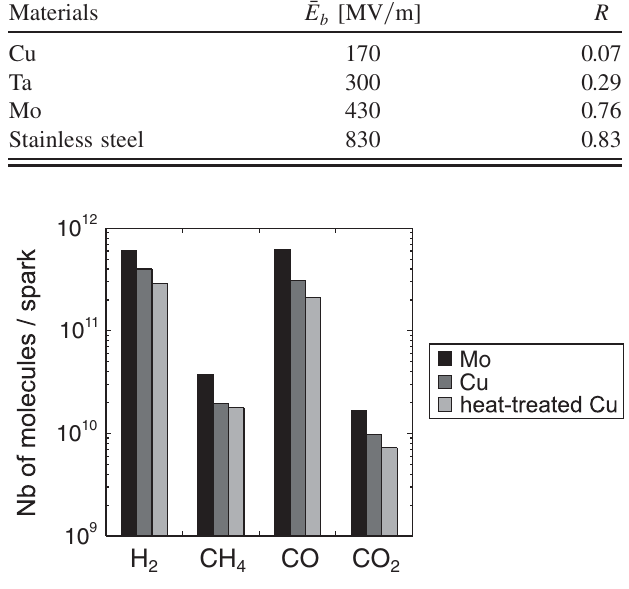
FIG. 11. Average number of molecules released per break- down, with conditioned Mo, Cu, and heat-treated Cu electrodes. Data were taken at BDR ¼ 1 , at 8.4 kV with Mo electrodes (0.95 J per breakdown), and at 7.7 kV with Cu and heat-treated Cu electrodes (0.8 J per breakdown). Values are averaged over several tens